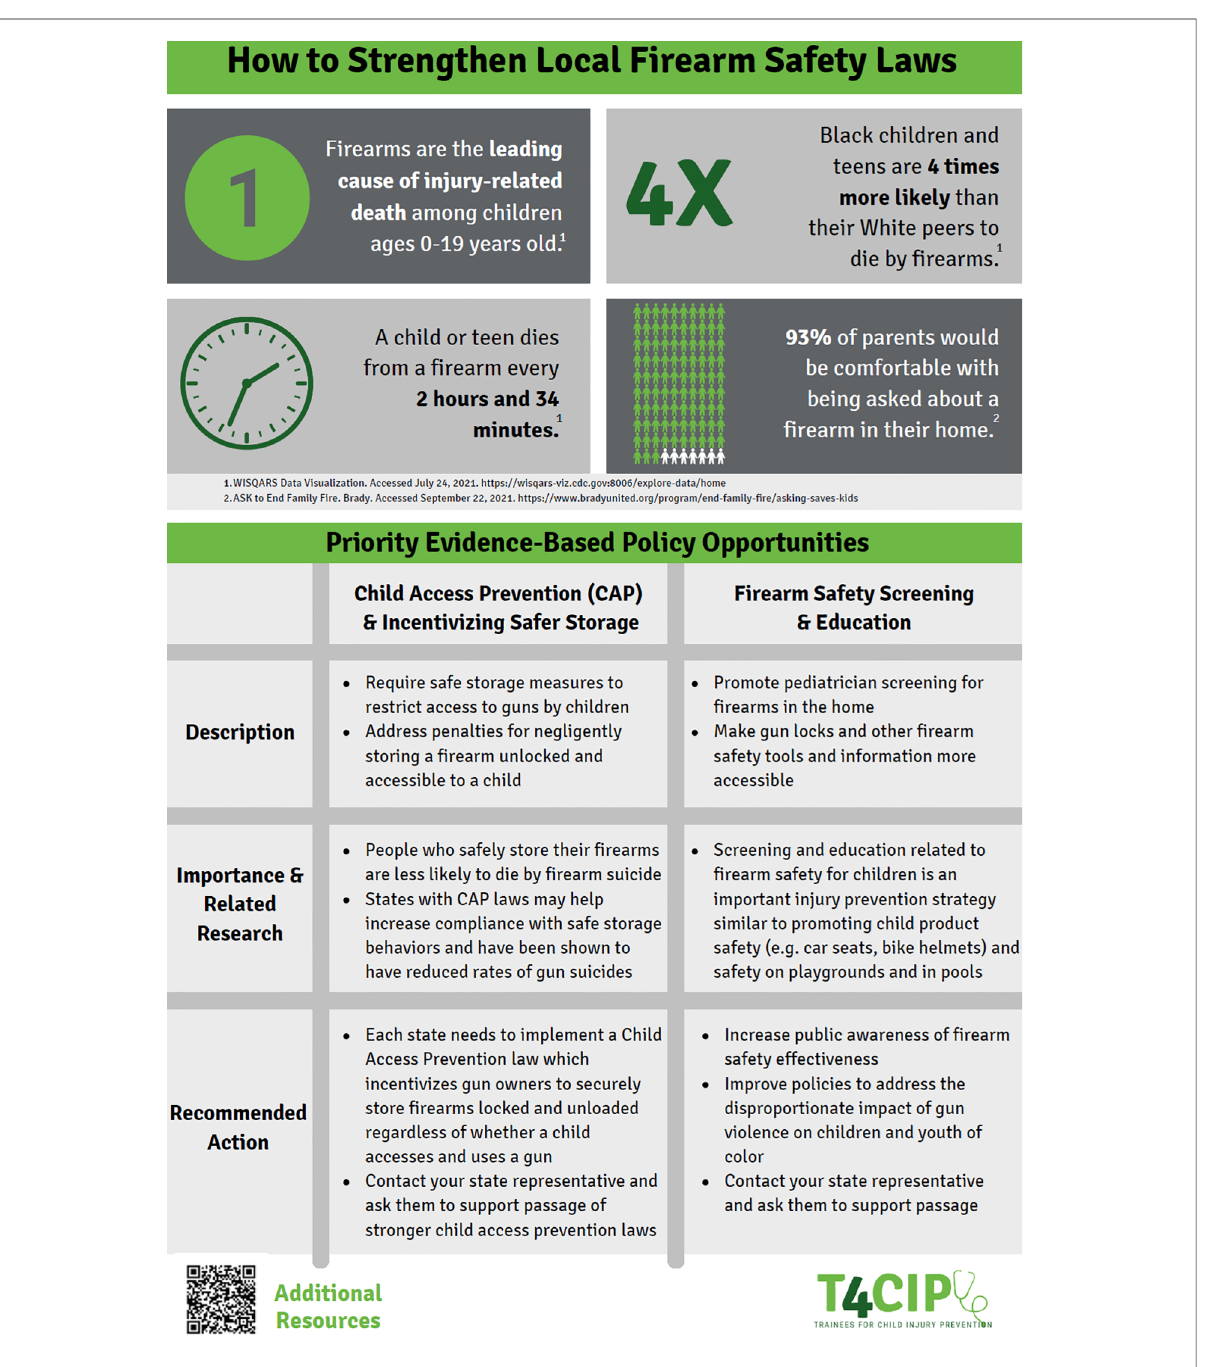
FIGURE 1 First policy “ Guide ” : local/regional advocacy part